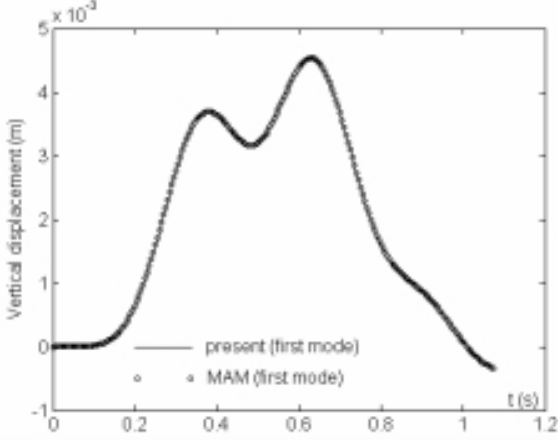
Fig. 3. The time history of vertical displacement of sprung mass.